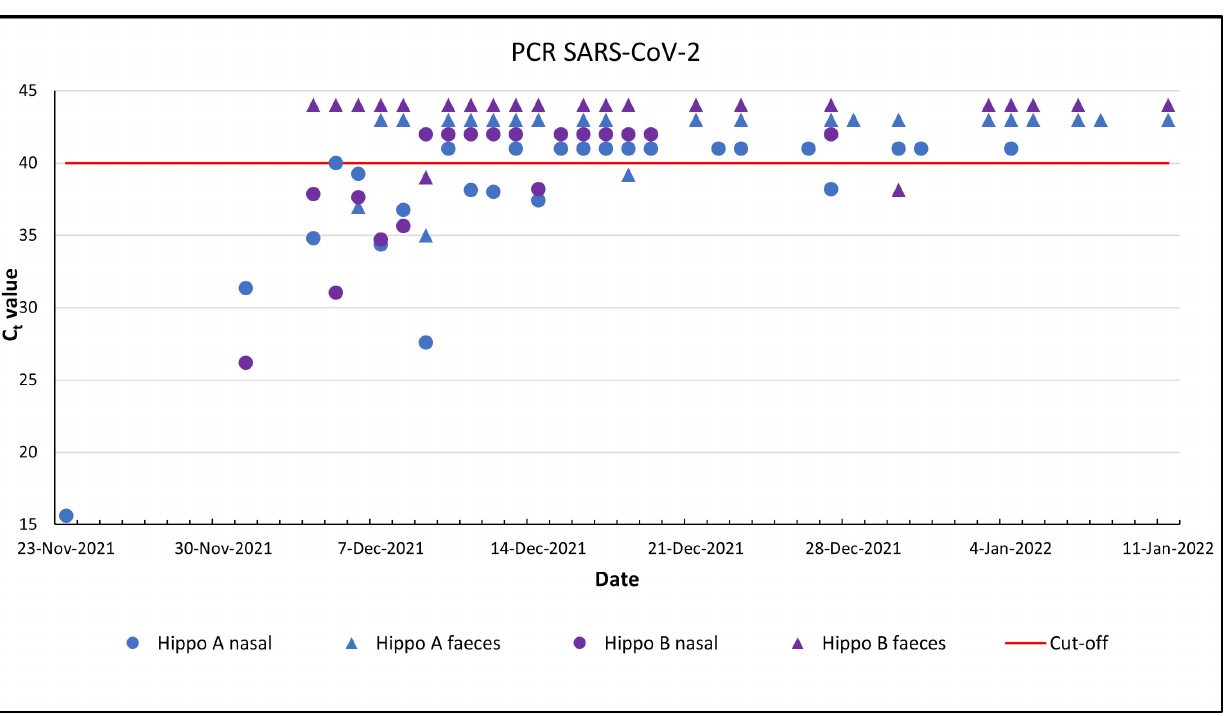
Figure 2. PCR detection of SARS-CoV-2 in nasal swabs and faeces of two hippos. For visual clarity, the negative samples (C t > 40) were given a fictitious number: 41, 42, 43 and 44. This virus belongs to lineage AY.125 or B.1.617.2.215 (a European lineage of the